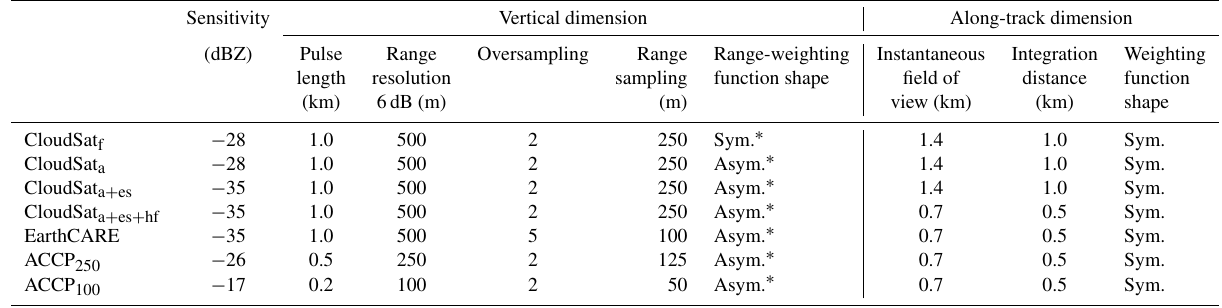
Table 1. Specifications of the forward-simulated radar configurations including information about whether or not their pulse-weighting function is symmetrical (sym.) or asymmetrical (asym.) in either the vertical or the along-track dimension. Sensitivity Vertical dimension